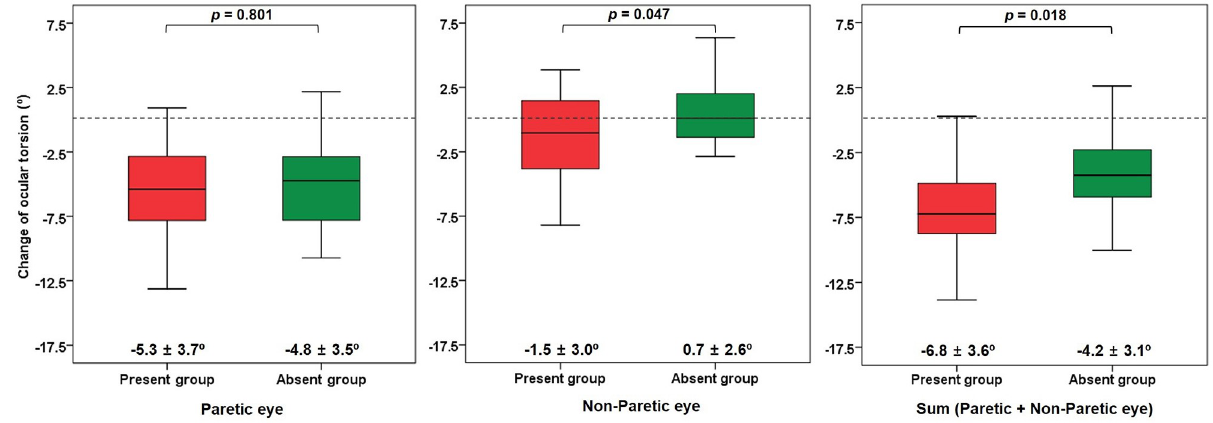
Fig 2. The change of ocular torsion in the paretic and non-paretic eyes according to the absence of the trochlear nerve.